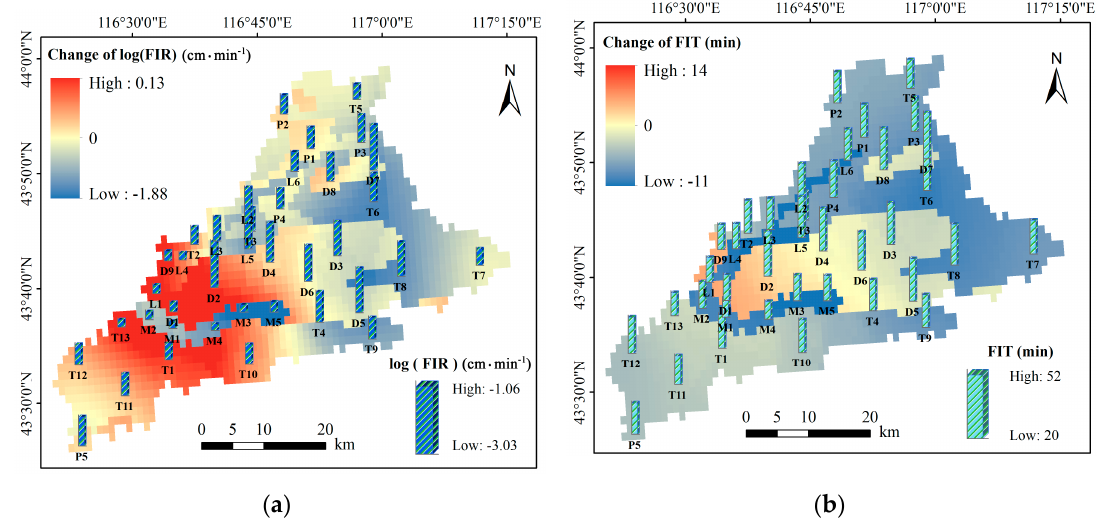
Figure 8. The change in the log-transformed final infiltration rate (FIR) ( a ) and final infiltration time (FIT) ( b ) between the soil type map and the experimental simulation map on the scale of 1 km × 1 km.